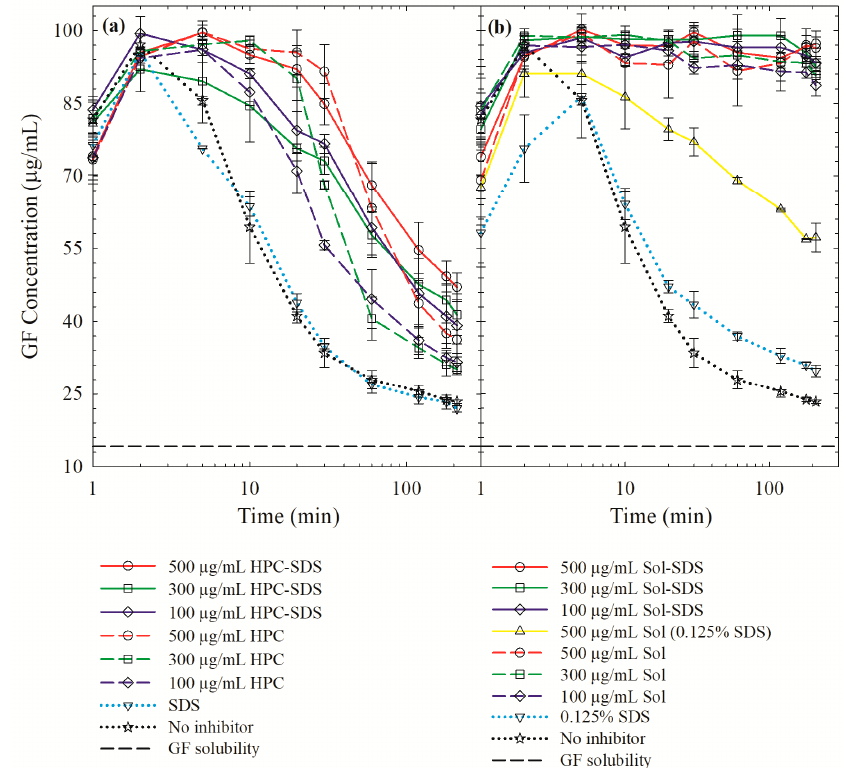
Figure 9. GF desupersaturation curves for a supersaturated 20 mL GF–acetone solution mixed with 1000 mL aqueous solutions of 500 µ g / mL, 300 µ g / mL, and 100 µ g / mL of HPC / Sol–SDS and HPC / Sol (corresponding to 1:5, 1:3, and 1:1 drug:polymer formulations), SDS only, and deionized water without any recrystallization inhibitor: ( a ) HPC and ( b ) Sol. Unless otherwise indicated, 0.0005% w / v (5 µ g / mL) SDS was used for the formulations with SDS. For aqueous 500 µ g / mL Sol–SDS solutions, SDS was used at 0.0005% w / v and 0.125% w / v . The initial concentration of GF right after mixing was targeted at 100 µ g / mL.